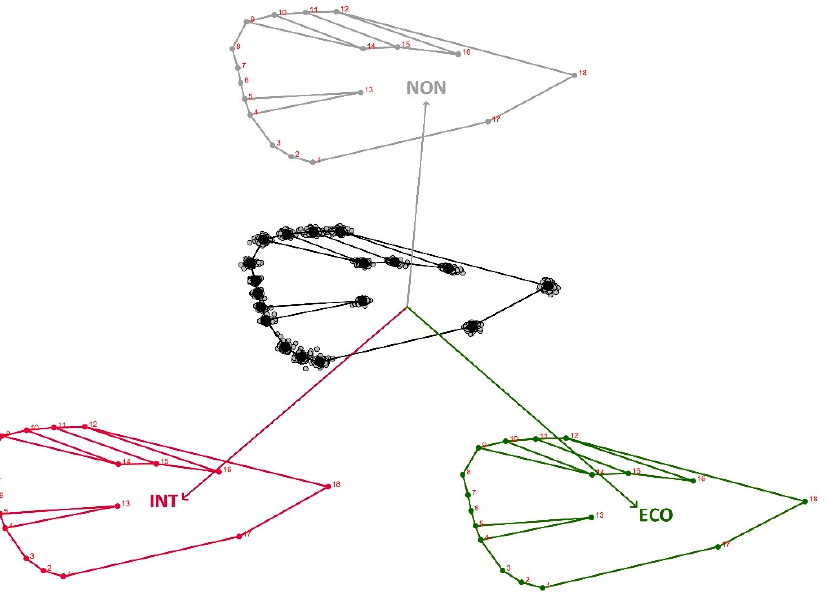
Figure 8. Average wing shape between different orchard populations. The middle wing represents the overall shape with the different averaged populations: red, integrated orchard (INT); green, organic orchard (ECO); gray: laboratory population (NON).